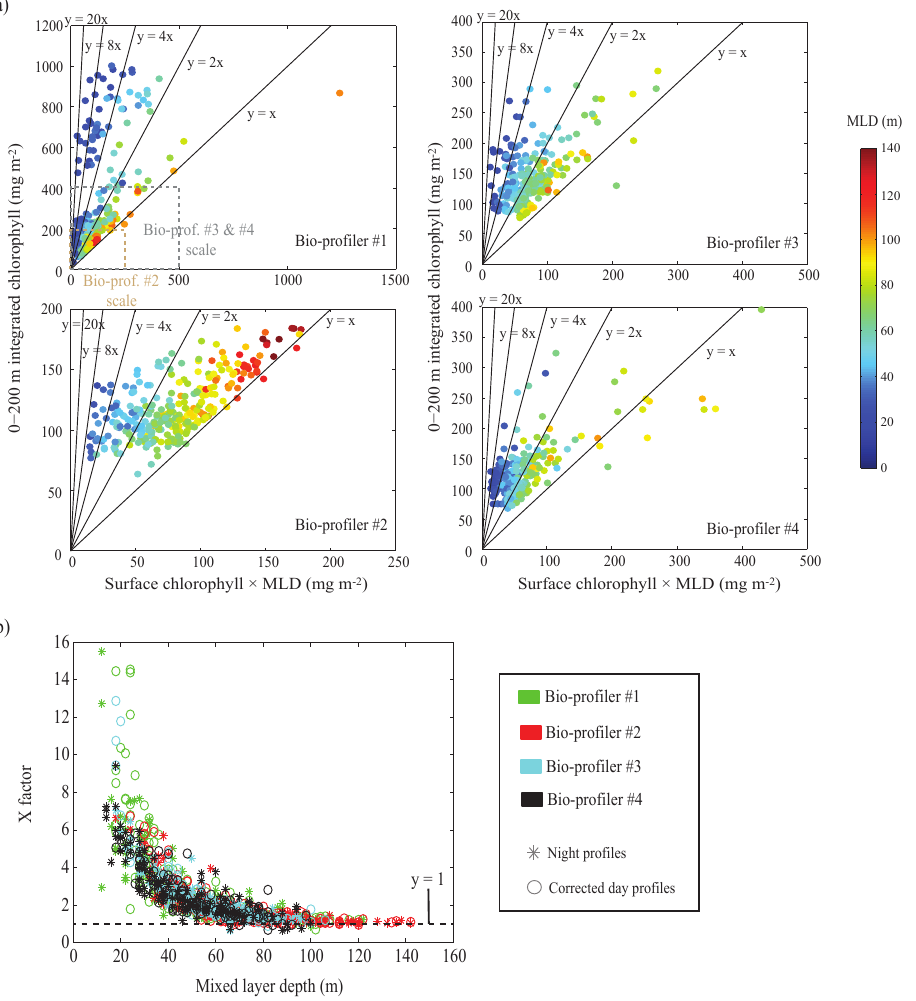
Figure 9. (a) Chlorophyll water column inventories (in mgm − 2 ) , estimated by multiplying surface chlorophyll concentrations by the mixed layer depth, compared to chlorophyll inventories (0–200m; in mgm − 2 ) recorded by the bio-profilers. Only night and unflagged day profiles are represented. The colour code shows the associated depth of the mixed layer (in m). The five lines y = x , y = 2 x , y = 4 x , y = 8 x , and y = 20 x are given as indicators to quantify the ratio between the “surface Chl a × MLD” product and the 0–200m integrated Chl a . (b) Representation of the X factor ( X = (0–200m integrated Chl a ) / (surface Chl a × MLD)) as a function of the mixed layer depth (in m), for the total data set. Symbols and colours are defined in the